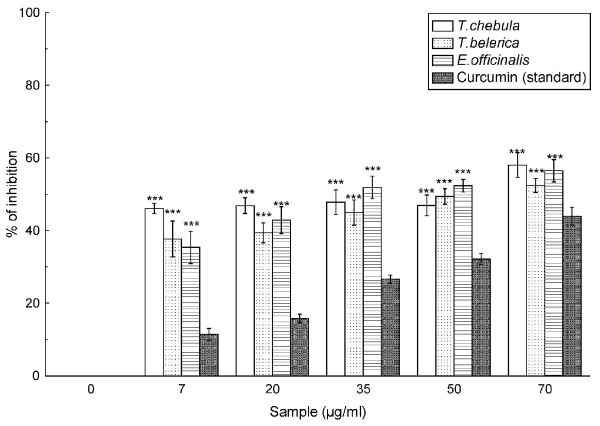
Nitric oxide radical scavenging assay. The nitric oxide radical scavenging activity of T. chebula, T. belerica and E. officinalis extracts and standard curcumin. The data represents the % of nitric oxide inhibition. Each value represents mean ± S.D. (n = 6). ***p < 0.001 vs 0 μg/ml.